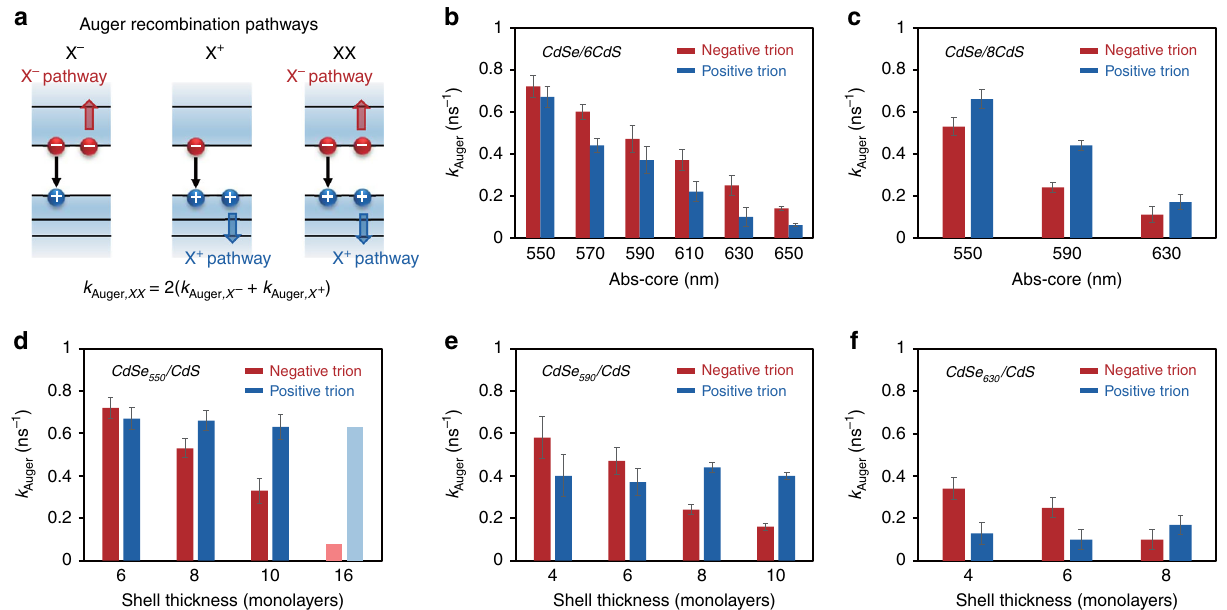
Fig. 3 Core size and shell thickness dependence of Auger recombination rates. a Illustration of Auger recombination pathways for negative trion (X − ), positive trion (X + ), and biexciton (XX), and the relation among three rates. b , c Core size dependence of Auger recombination rates of X − (red) and X + (blue) for CdSe/CdS core/shell quantum dots (QDs) with four and eight monolayers of shells, respectively. d – f Shell thickness dependence of Auger recombination rates of X − (red) and X + (blue) for CdSe/CdS core/shell QDs with the fi rst-exciton absorption peak of core at 550, 590, and 630 nm, respectively. The data for CdSe/CdS core/shell QDs with the fi rst-exciton absorption peak of core at 550 nm and 16 monolayers of shell in d (light blue and light red) is from ref. 25 . Error bars are de fi ned as